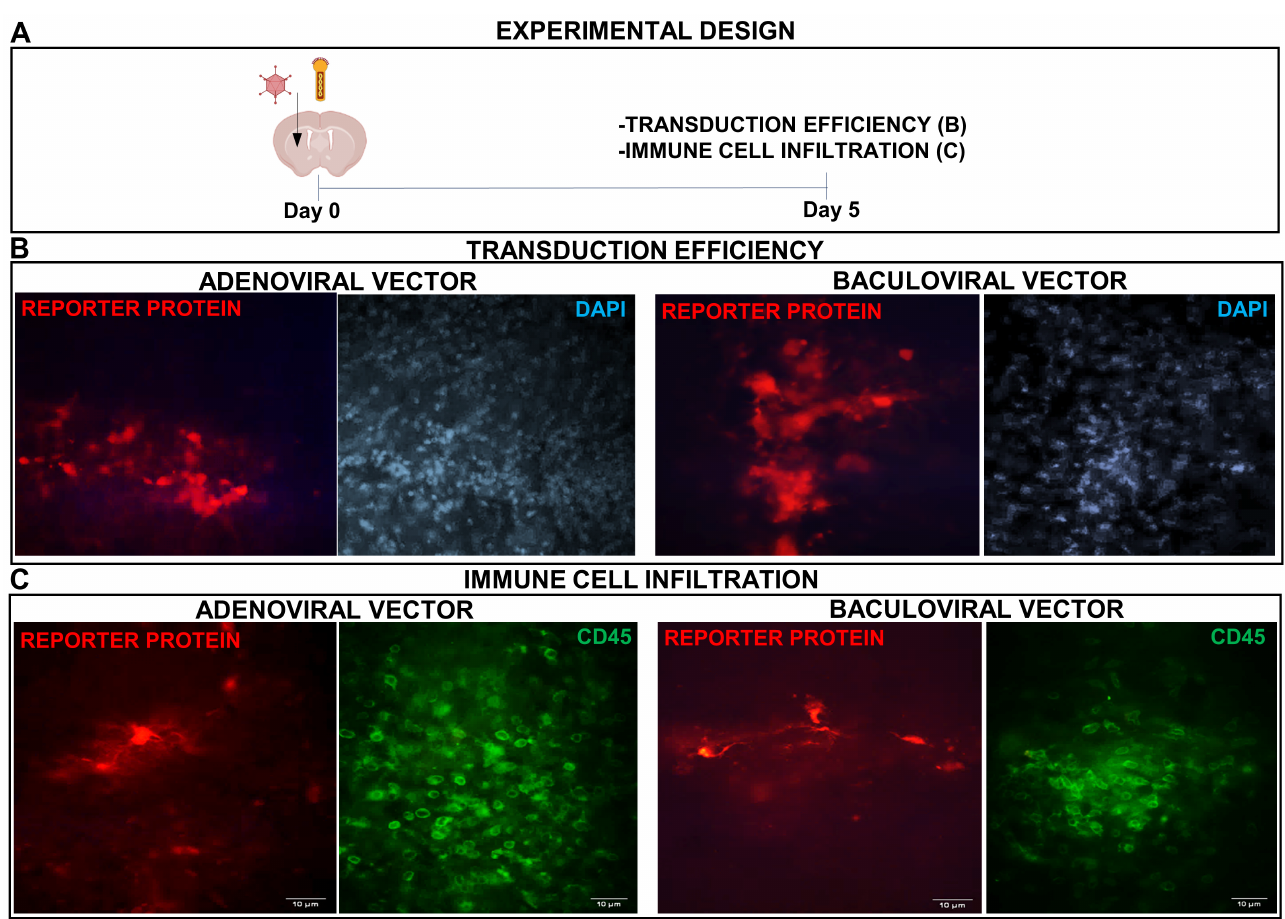
Figure 5. AdV- and BV-mediated transgene delivery in mouse brain. ( A ) C57Bl/6 mice were inoculated into the right striatum with AdV (10 7 PFU in 3 µ L) or BV (5 × 10 8 PFU in 5 µ L). After 5 days, the expression of the reporter protein dTomato (red) was evaluated by fluorescent microscopy and nuclei were stained with DAPI ( B ) or CD45 cells were detected by immunofluorescence (green) ( C ). Representative microphotographs are